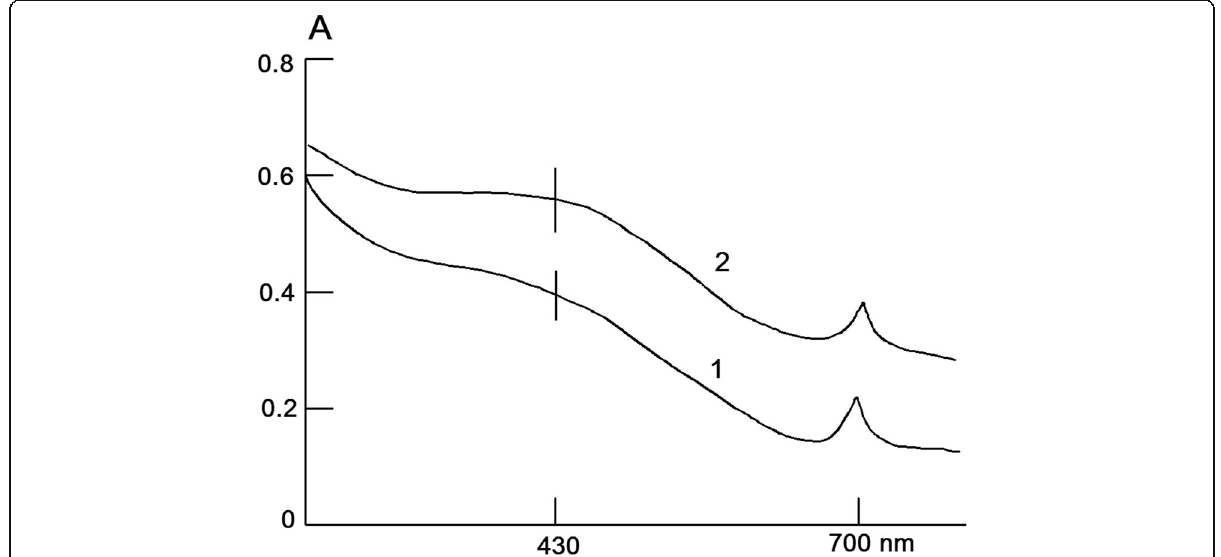
Fig. 2 Optical absorption spectra of suprol dissolved in 0.005 M PPB at pH 9.5 within 2 h (1) and 30 h (2) at 4 °C after obtaining ( p < 0.05 n =